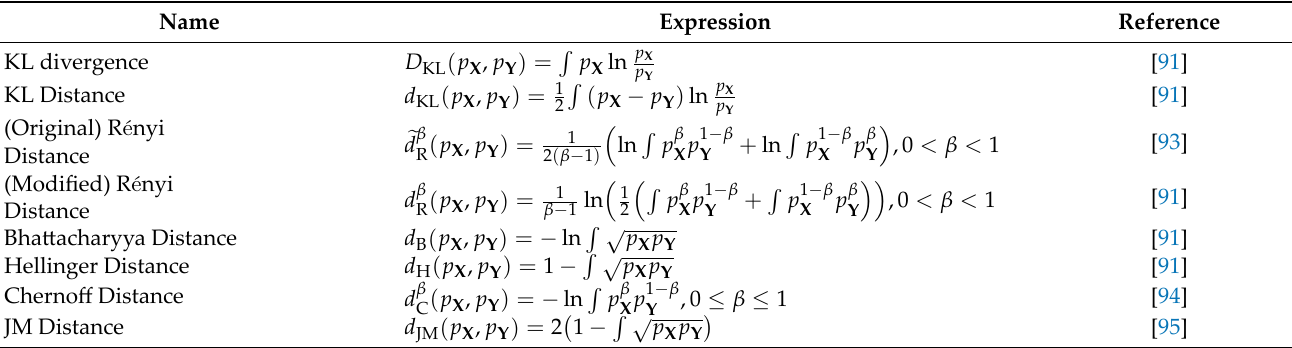
Table 5. Expressions of some typical stochastic